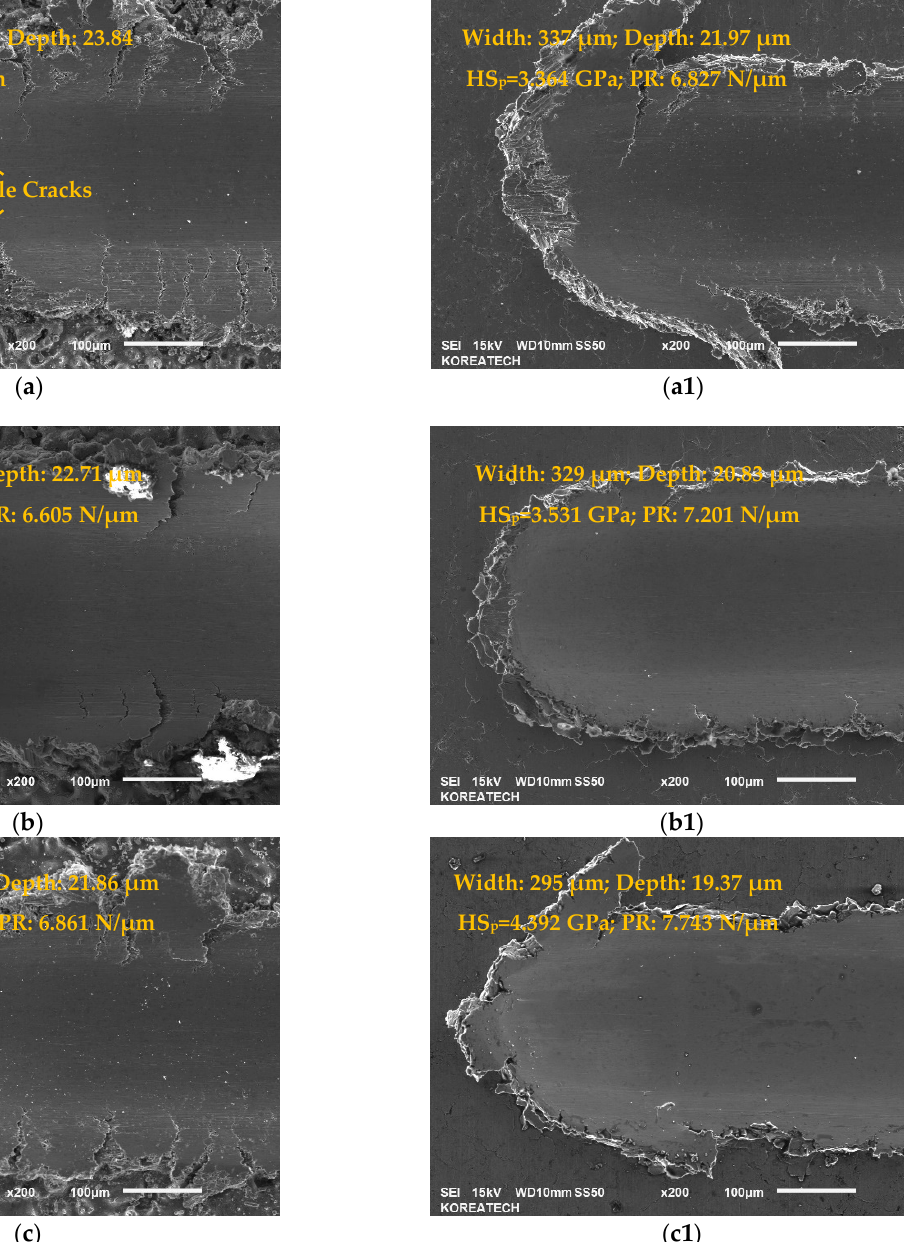
Figure 8. SEM images of the ends of scratch grooves showing scratch-induced grooves formed on the surface of the carburized, pre-, and post-carburized UNSM-treated KHR 45A steels. ( a ) carburized KHR 45A (A), ( b ) pre-carburizing UNSM-treated KHR 45A (A), ( c ) carburized KHR 45A (B), ( a1 ) carburized KHR 45A (A)+UNSM, ( b1 ) UNSM+ carburized KHR 45A (A)+UNSM and ( c1 ) carburized KHR45A (B)+UNSM.